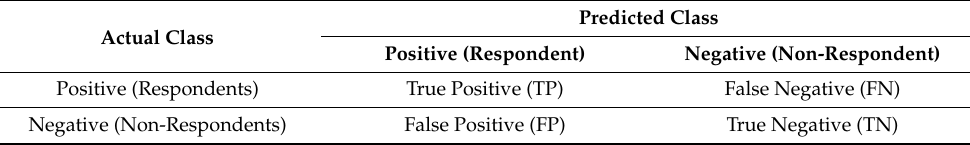
Table 3. Confusion